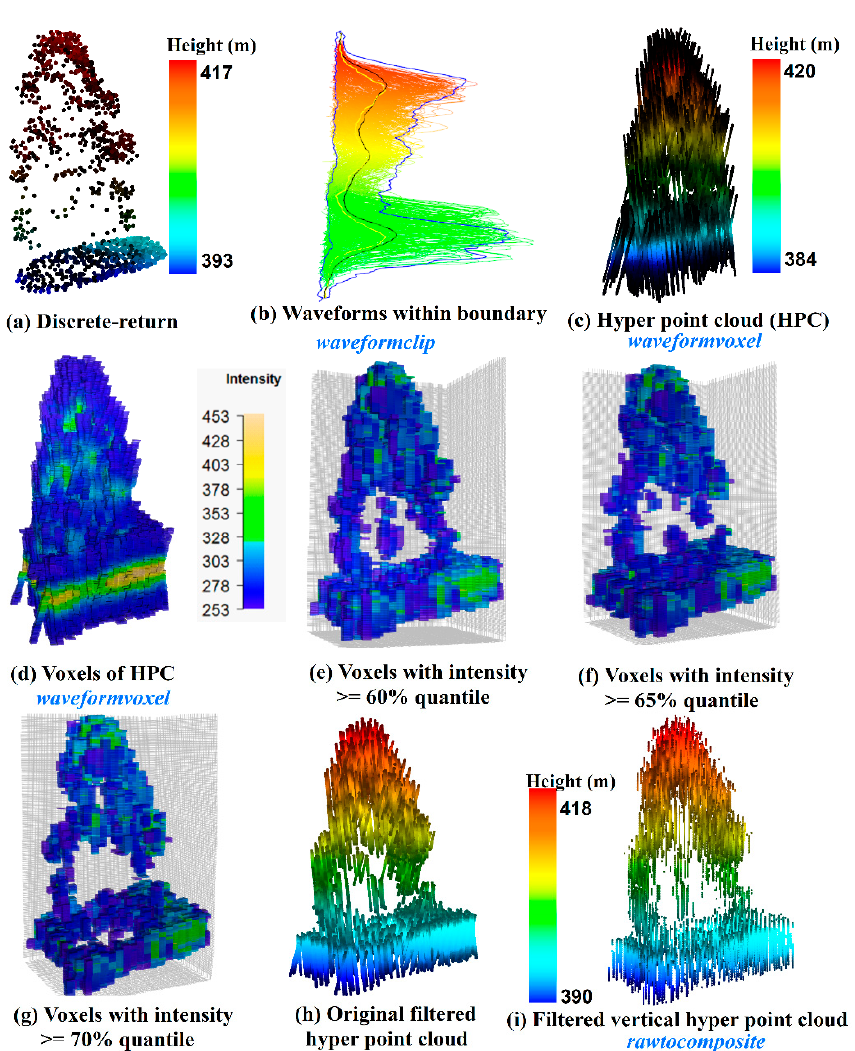
Figure 8. Visualization of an individual tree using ( a ) discrete-return LiDAR point cloud and waveform LiDAR data with di ff erent processing steps. ( b ) Waveforms being selected within one tree boundary using waveformclip function; ( c ) The Hyper Point Cloud (HPC) generated from waveforms of ( b ) using hyperpointcloud function; ( d ) Voxelization product from the HPC using waveformvoxel function with res = c (0.8, 0.8 0.15) (colored by intensity); ( e ) Voxelized HPC after implementing intensity filtering (intensity > = 60% of maximum intensity, colored by intensity); ( f ) Voxelized HPC after implementing intensity filtering (intensity >= 65% of maximum intensity, colored by intensity); ( g ) Voxelized HPC after implementing intensity filtering (intensity > = 70% of maximum intensity, colored by intensity); ( h ) Original HPC after using 60% intensity filter (colored by height); ( i ) The vertical HPC after using both rawtocomposite function and 60% intensity filter (colored by height); Functions are colored in